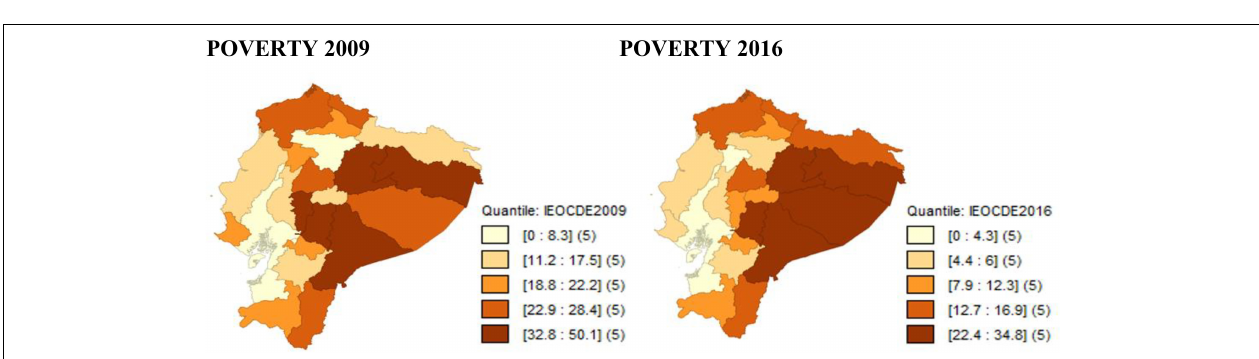
FIGURE 2 | Evolution of poverty in Ecuador at the provincial level, using per- capita income. Source: Own elaboration with data from ENEMDU 2009 and 2016.